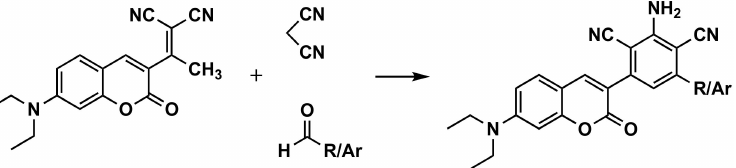
Figure 9. One of the synthetic routes to obtain 3-phenylcoumarins: construction of the benzene ring at position 3 of the